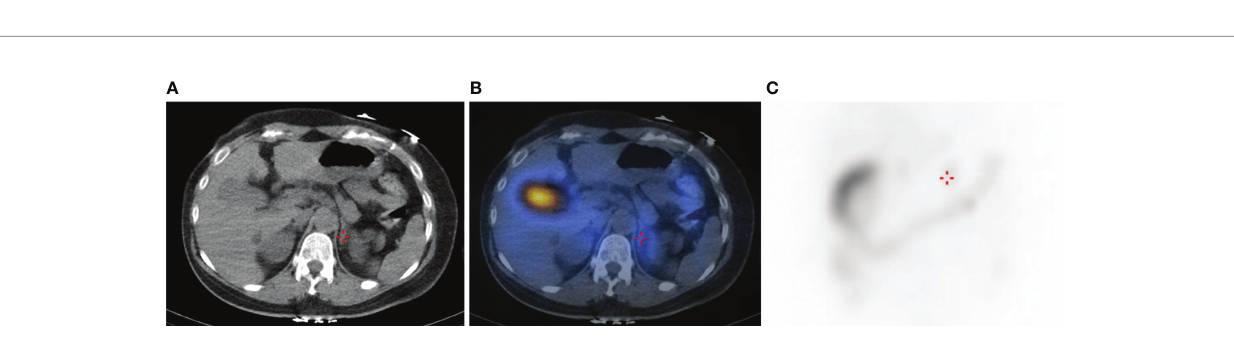
FIGURE 2 | CT and NP-59 SPECT image of the abdomen showing a focus of increased tracer uptake in the region of the left adrenal gland (crosshairs). (A) Abdominal CT image of the axial plane shows a 0.6 cm left adrenal nodule. (B) Fused SPECT/CT image shows focal uptake at the left adrenal gland, indicating aldosterone-producing nodule. (C) Planar image shows mildly intense focal lesion over the left suprarenal